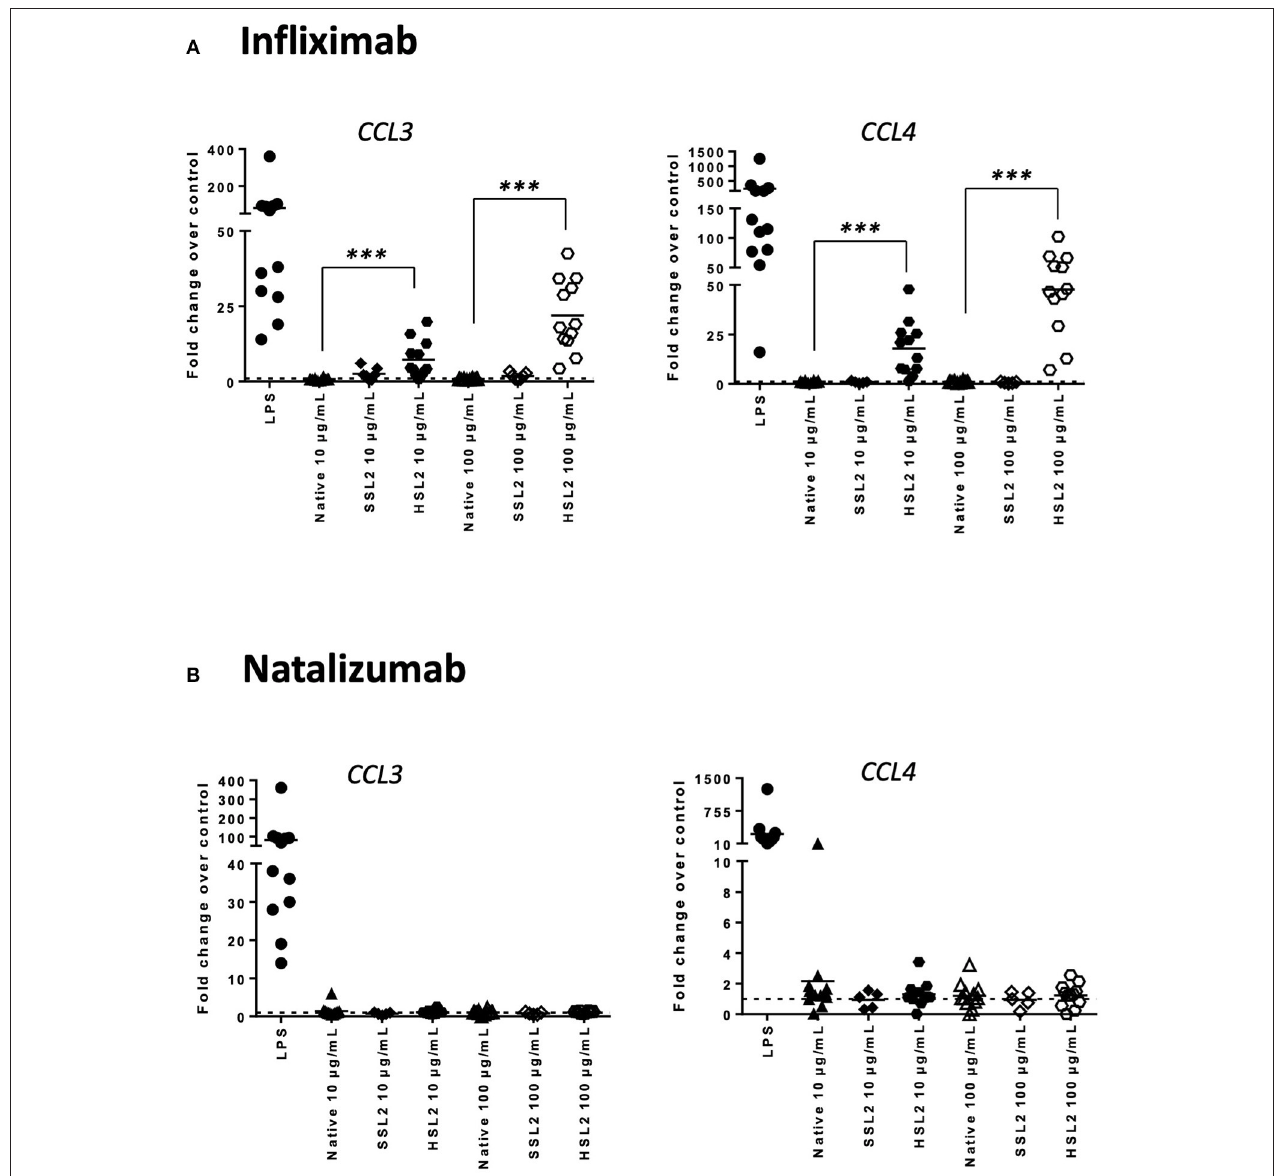
FIGURE 4 | Expression of chemokines CCL3 and CCL4 mRNA in moDC treated with native or aggregated infliximab (A) and natalizumab (B) . Immature moDC were treated with native or stressed (SSL2 or HSL2) antibodies. Transcript expression was measured after 6h using real-time RT-PCR. Results are expressed as fold change over PBS control. The results from 12 independent experiments are shown. *** p <